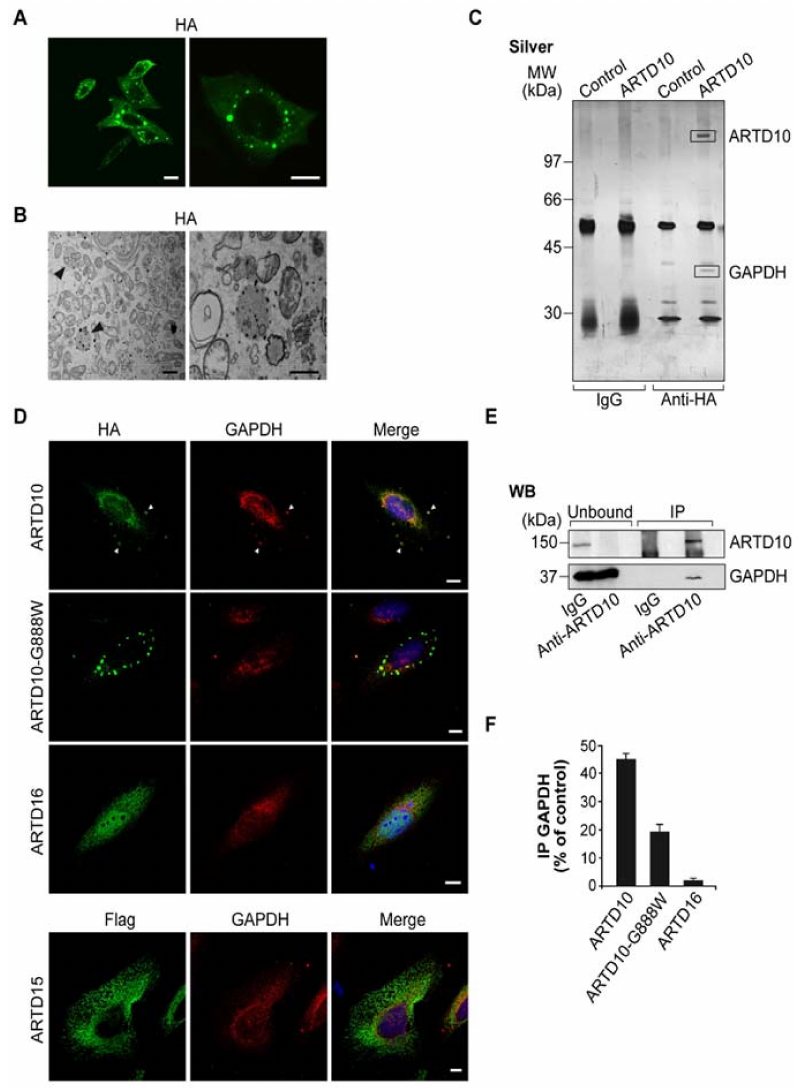
Figure 1. ARTD10/PARP10 interacts with GAPDH. ( A ) Representative immunofluorescence staining of ARTD10 (green) in CHO cells transiently transfected with HA-ARTD10; ( B ) Representative electron microscopy of immuno-gold staining of ARTD10 (black dots, indicated by arrows) in CHO cells overexpressing ARTD10 wt. ( A , B ) The two panels show two different samples with images taken with different magnifications. Data are representative of at least four different experiments; ( C ) Representative analysis of lysates (2 mg protein) from CHO cells transfected with empty vector (control) or HA-ARTD10 were immunoprecipitaed with an anti-HA (Hemagglutinin) antibody. Proteins were separated by 10% SDS-PAGE and revealed by silver staining. Differentially immunoprecipitated proteins were excised from gels and identified by MALDI-TOF mass spectrometry (boxed bands) as ARTD10 and GAPDH; ( D ) Representative immunofluorescence of HeLa cells transiently transfected with the indicated HA-tagged ARTD enzymes or with the FLAG-tagged ARTD15, stained with anti-HA (HA; green) or anti-FLAG (FLAG; green) and anti-GAPDH (GAPDH: red) antibodies. Cells transfected with the ARTD10-G888W mutant, as compared to cells transfected with wt protein, tend to form larger cell-bodies. ( C , D ) Data are representative of three independent experiments. Scale bars, 10 µ m ( A , D ), 0.3 µ m ( B ); ( E ) Representative co-immunoprecipitation of endogenous ARTD10 and GAPDH in HL60 cell total lysates. Western blotting (WB) was performed using an anti-GAPDH antibody; ( F ) Quantification of GAPDH immunoprecipitation in HeLa cells transiently transfected with the indicated HA-tagged ARTD enzymes. ( E , F ) Data are representative of two independent experiments. MW = Molecular